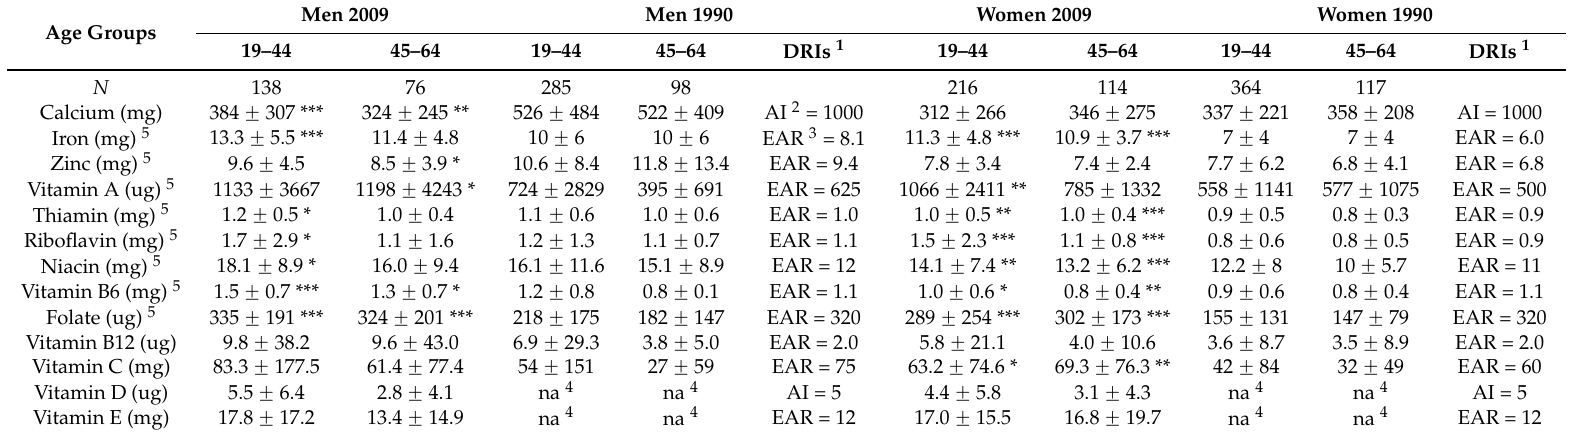
Table 2. Mean micronutrient intake in 19–64-year-old men and women in 1990 [10] and